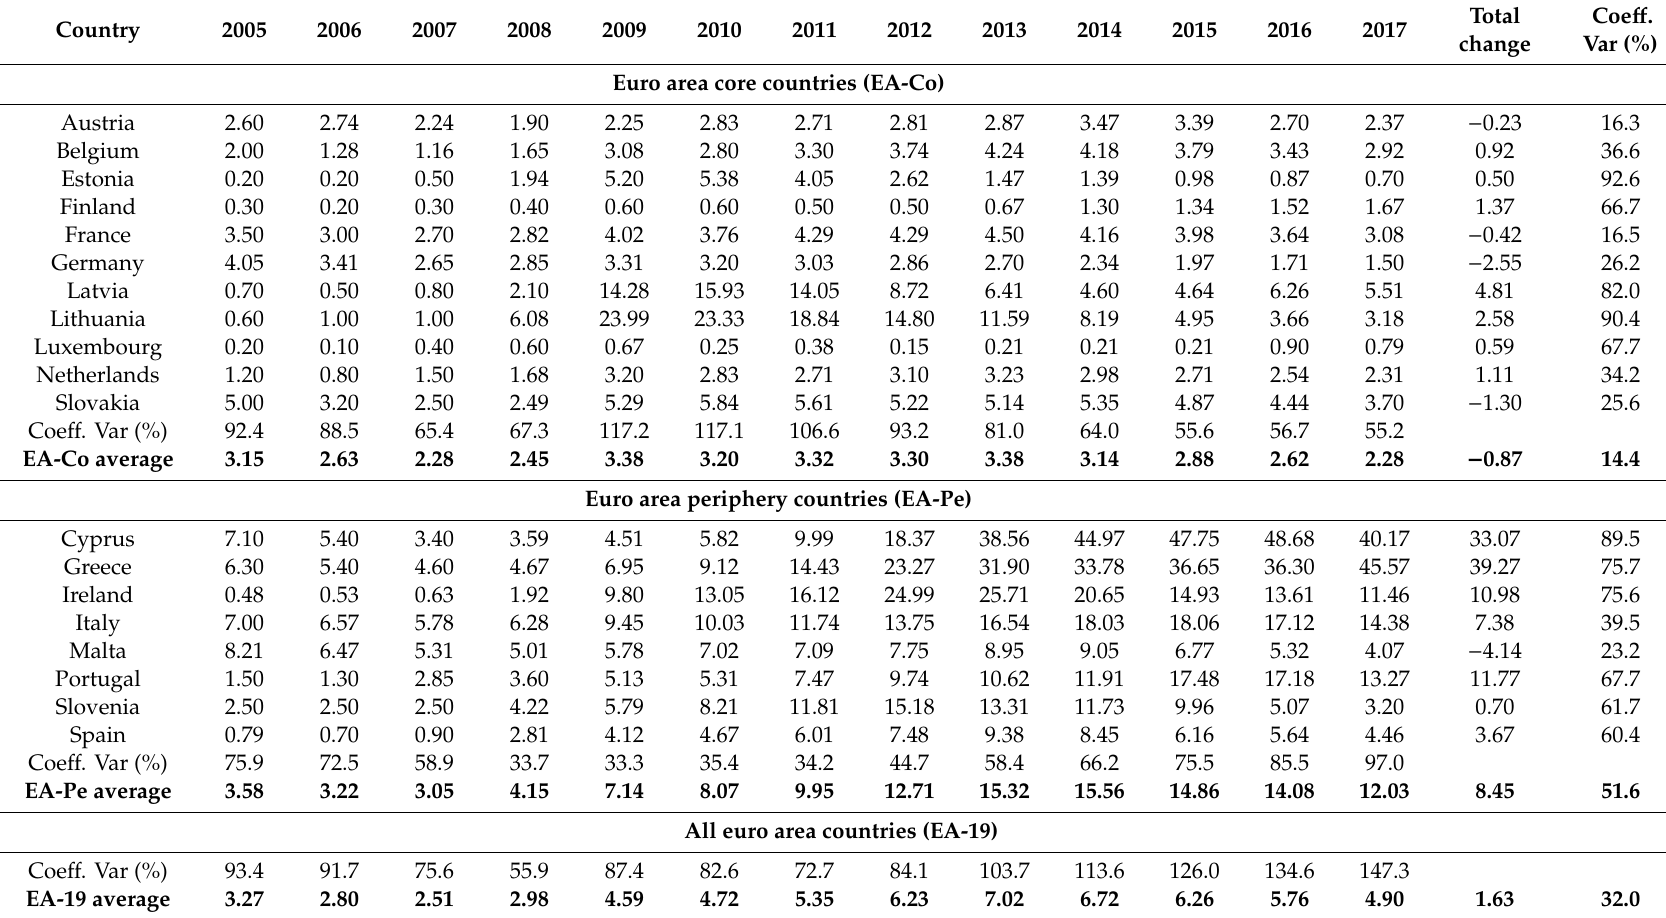
Table 4. Evolution of credit risk (non-performing loan (NPL) ratio).